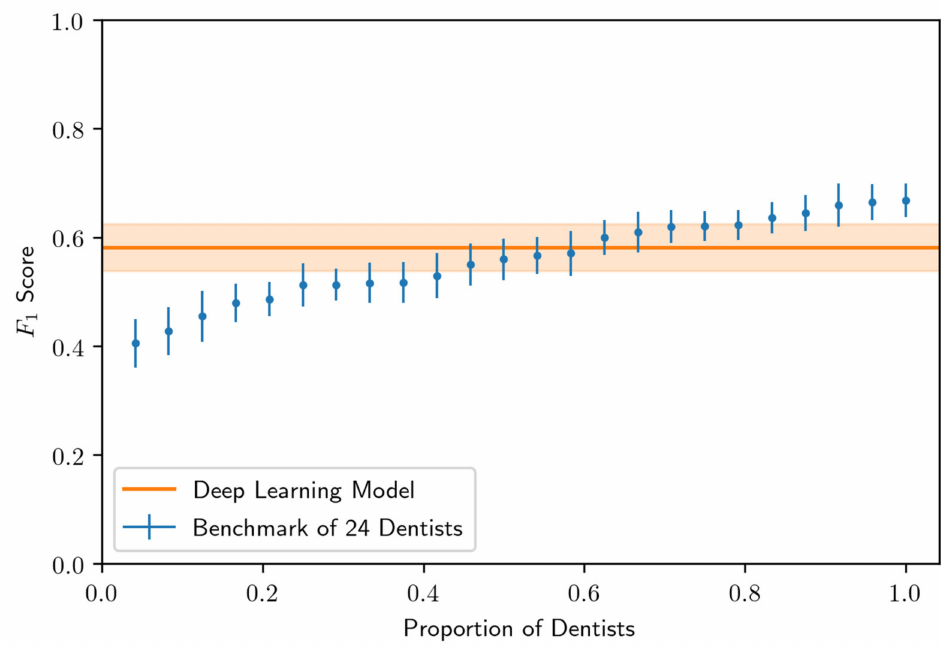
Figure 4. Comparison of 24 OMF surgeon and model predictions in terms of F 1 score on the testing data set. The model threshold was chosen so that the F 1 score was maximized on the validation data set. Standard errors (whiskers and uncertainty bands) were computed via a jackknife